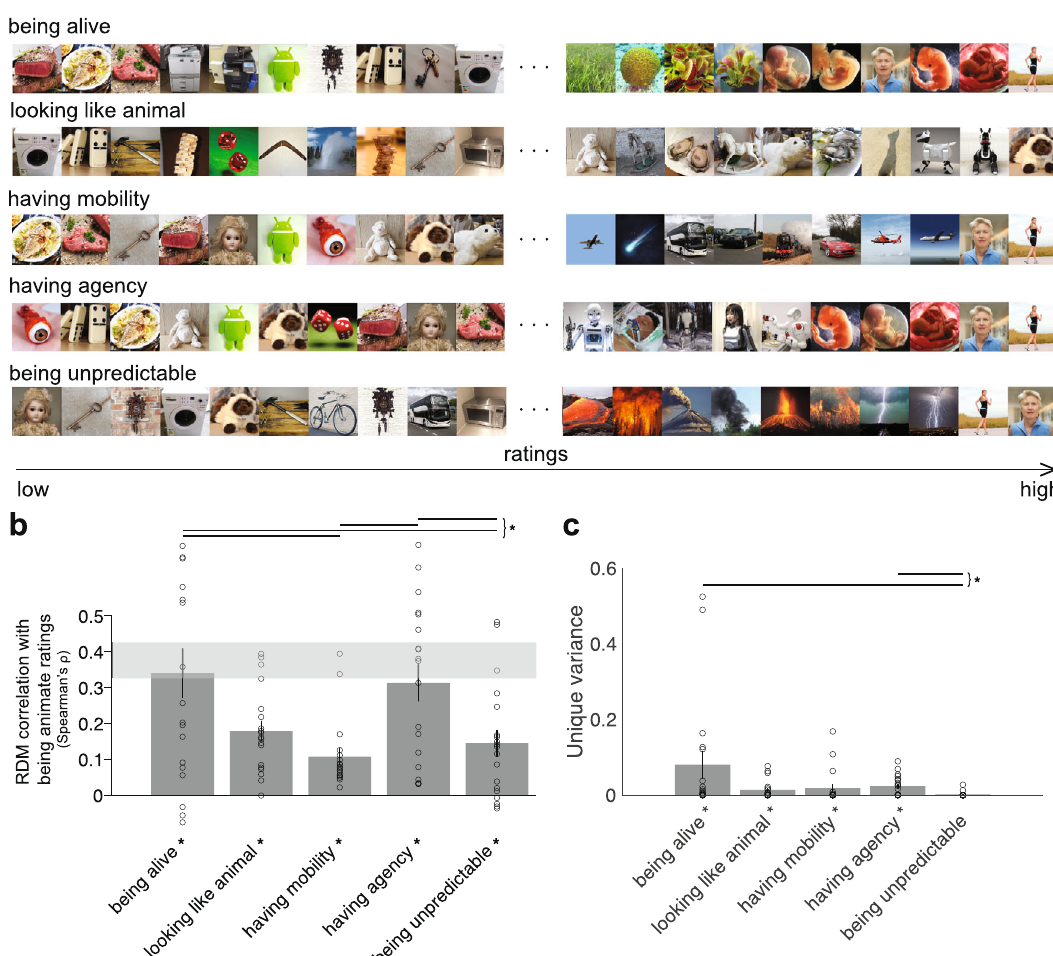
Fig. 4 Dimensions of animacy and animacy ratings. a Order of images with lowest and highest ratings on each animacy dimension. Out of 128 images, we show ten lowest and ten highest rated images on each animacy dimension. b Animacy dimension representational dissimilarity matrices (RDMs) comparisons with animacy ratings ( “ being animate ” ) RDMs. Bars show the correlation between the animacy ratings RDMs and each animacy dimension RDM of 19 participants. A signi fi cant correlation is indicated by an asterisk (one-sided Wilcoxon signed-rank test, p < 0.05 corrected). Error bars show the standard error of the mean based on single-participant correlations, i.e., correlations between the single-participant animacy ratings RDMs and animacy dimension RDM. Circles show single-participant correlations. The grey bar represents the noise ceiling, which indicates the expected performance of the true model given the noise in the data. Horizontal lines show signi fi cant pairwise differences between model (here dimensions of animacy) performance ( p < 0.05, FDR corrected across all comparisons), an asterisk to the right of horizontal lines indicates their signi fi cance. c Unique variance of each animacy dimension in explaining animacy ratings computed using a general linear model (GLM). For each animacy dimension m, the unique variance was computed by subtracting the total variance explained by the reduced GLM (excluding the dimension of interest) from the total variance explained by the full GLM. Speci fi cally, for dimension m, we fi t GLM on X = “ all dimensions but m ” and Y = data, then we subtract the resulting R2 from the total R2 ( fi t GLM on X = “ all dimensions ” and Y = data). We used non-negative least squares to fi nd optimal weights. A signi fi cant unique variance is indicated by an asterisk (one-sided Wilcoxon signed-rank test, p < 0.05 corrected). The error bars show the standard error of the mean based on single-participant unique variance. Circles show single-participant unique variance. Horizontal lines show signi fi cant pairwise differences between model performance ( p < 0.05, FDR corrected across all comparisons), an asterisk to the right of horizontal lines indicates their signi fi